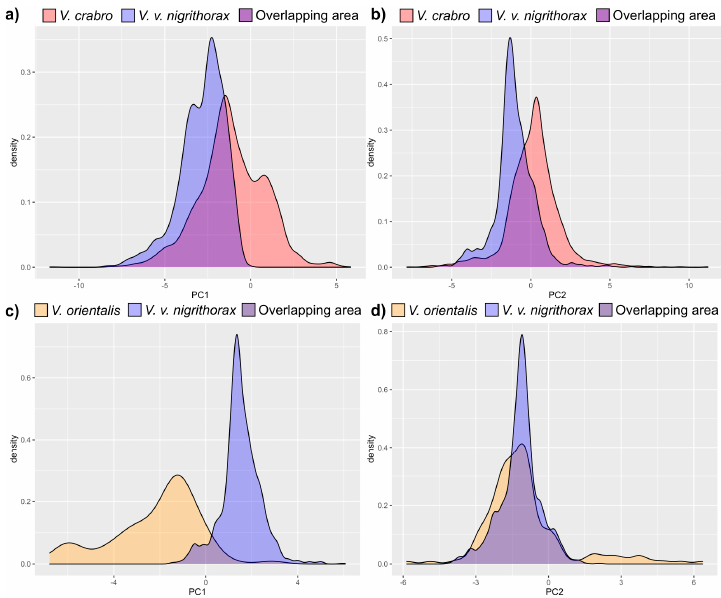
Figure 5. Density plots of the first two components (PC1 and PC2) of the PCA-env analyses between Vespa velutina nigrithorax (blue) and the two native Vespa species, respectively V. crabro (red, a , b ) and V. orientalis (yellow, c , d ). Table 1. Overlapping of the density functions among species in the study area ( Vespa velutina nigrithorax versus, respectively, V. crabro and V. orientalis ) and in the areas of co-occurrence ( V. v. nigrithorax versus V. crabro ). For each variable, the percentage of overlapping and the standard error (SE) of the estimated overlap is reported (the mean and the standard deviation values are reported in Table S2).